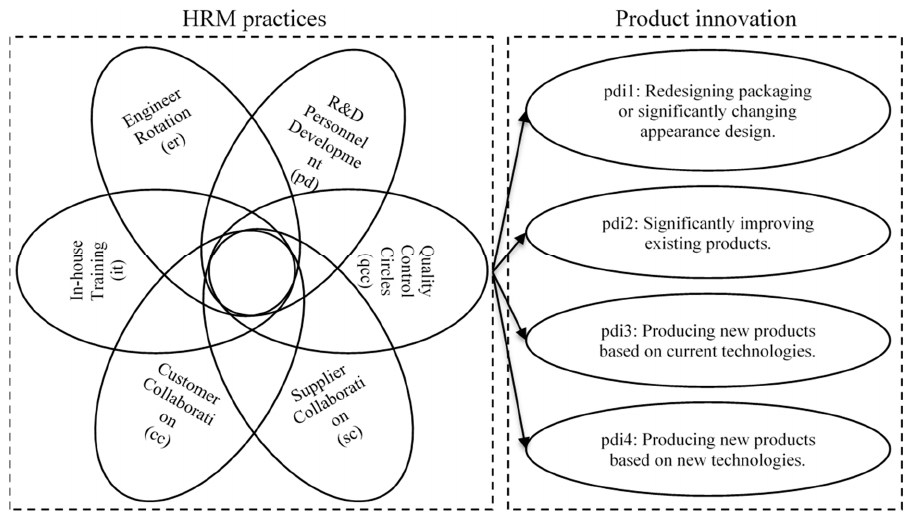
Figure 1. Theoretical model.